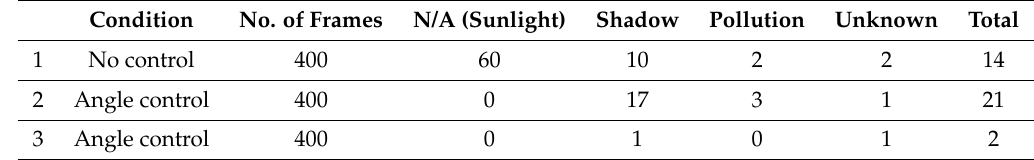
Figure 16. Hot spots caused reflection due to sunlight, solid on PV surface, and shadows. Table 2. Results of hotspot detection and